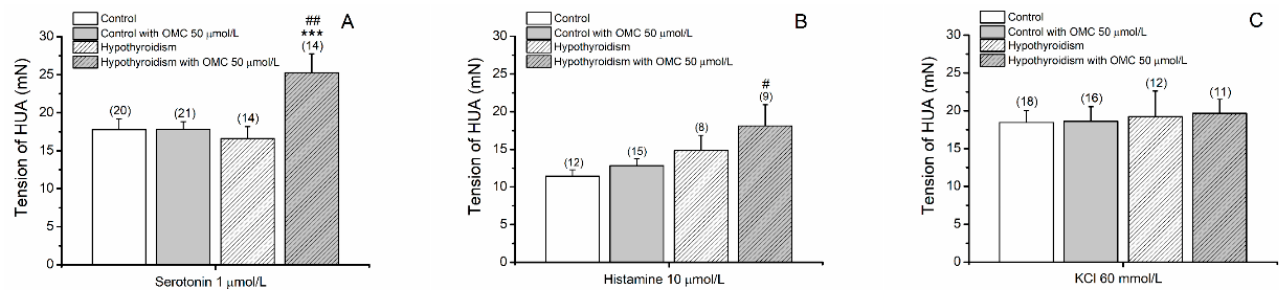
Figure 1. Tension (mN) (at time 15 min) of the human umbilical artery (HUA) rings without (control) and with hypothyroidism incubated with octylmethoxycinnamate (OMC, 0 and 50 µmol/L) and contracted by ( A ) serotonin (5-HT; 1 µmol/L), ( B ) histamine (His; 10 µmol/L) and ( C ) potassium chloride (KCl; 60 mmol/L). Each bar represents the mean, vertical lines the S.E.M. and the number within brackets the n . Asterisk * represents a significant difference versus incubation: *** p < 0.001, and hashtag # represents a significant difference versus hypothyroidism: # p < 0.05 and ## p < 0.01; two-way ANOVA method followed by Holm–Sidak post-hoc tests.